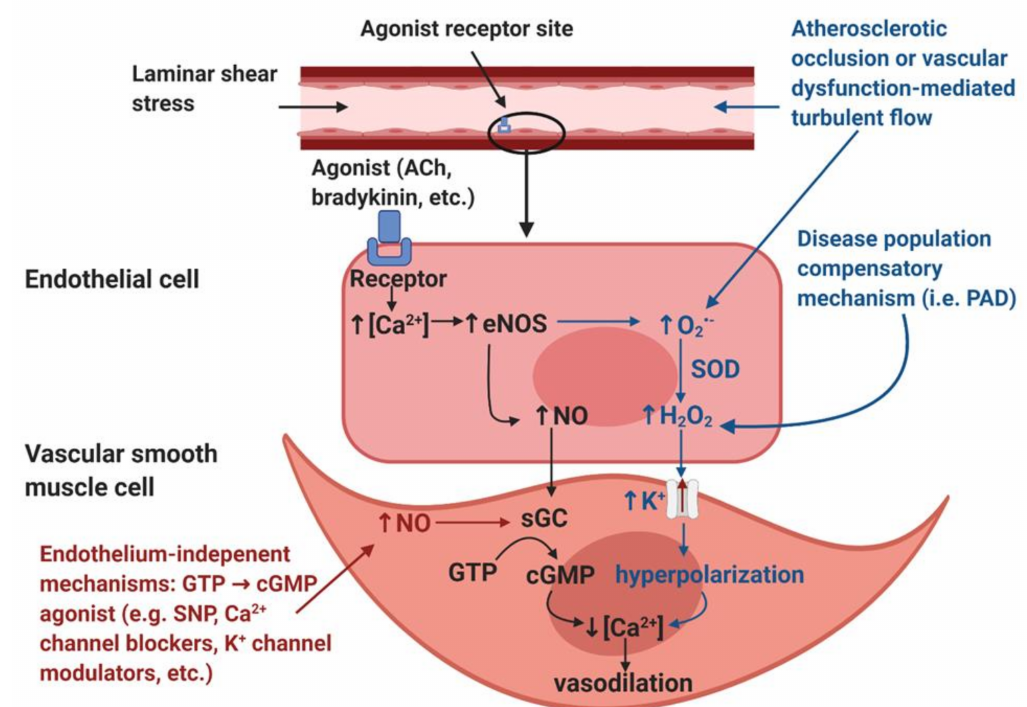
Figure 1. Illustration of the nitric oxide (NO)-mediated endothelial-mediated vasodilation pathway (black), the hypothesized disease population endothelial-dependent compensatory mechanism (blue), and endothelium-independent modulators of vasodilation (red). Image created with